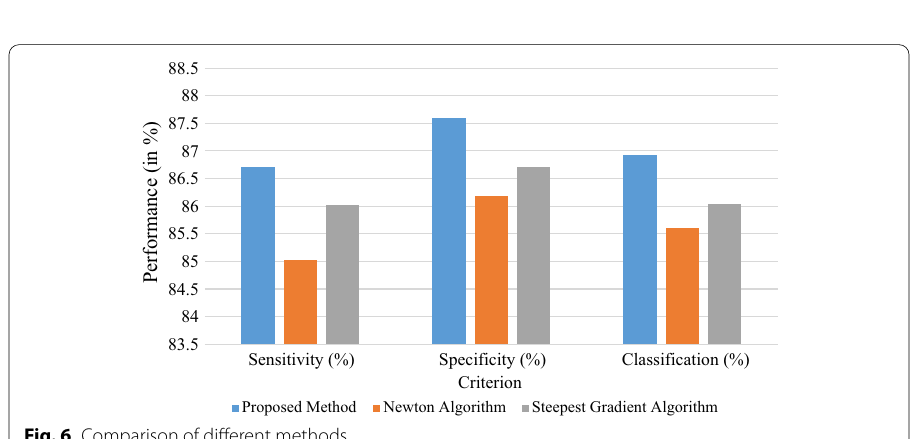
Fig. 6 Comparison of different